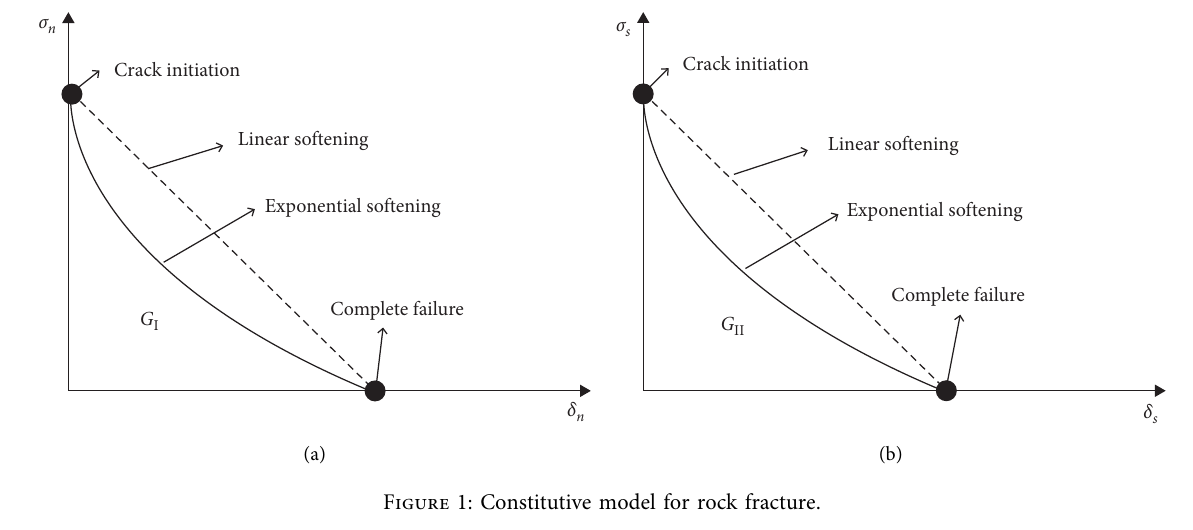
Figure 1: Constitutive model for rock fracture.